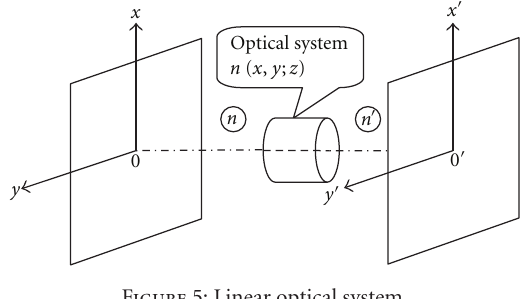
Figure 5: Linear optical